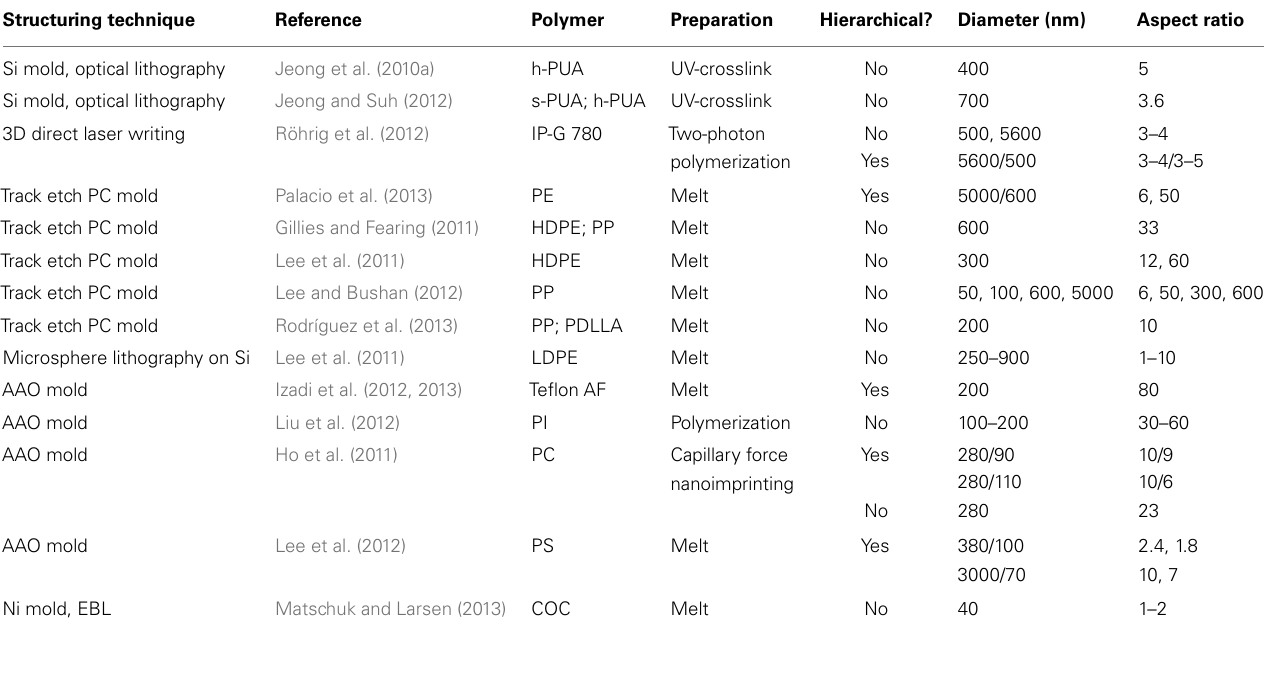
Table 1 | Summary of nanostructured dry adhesives in recent literature